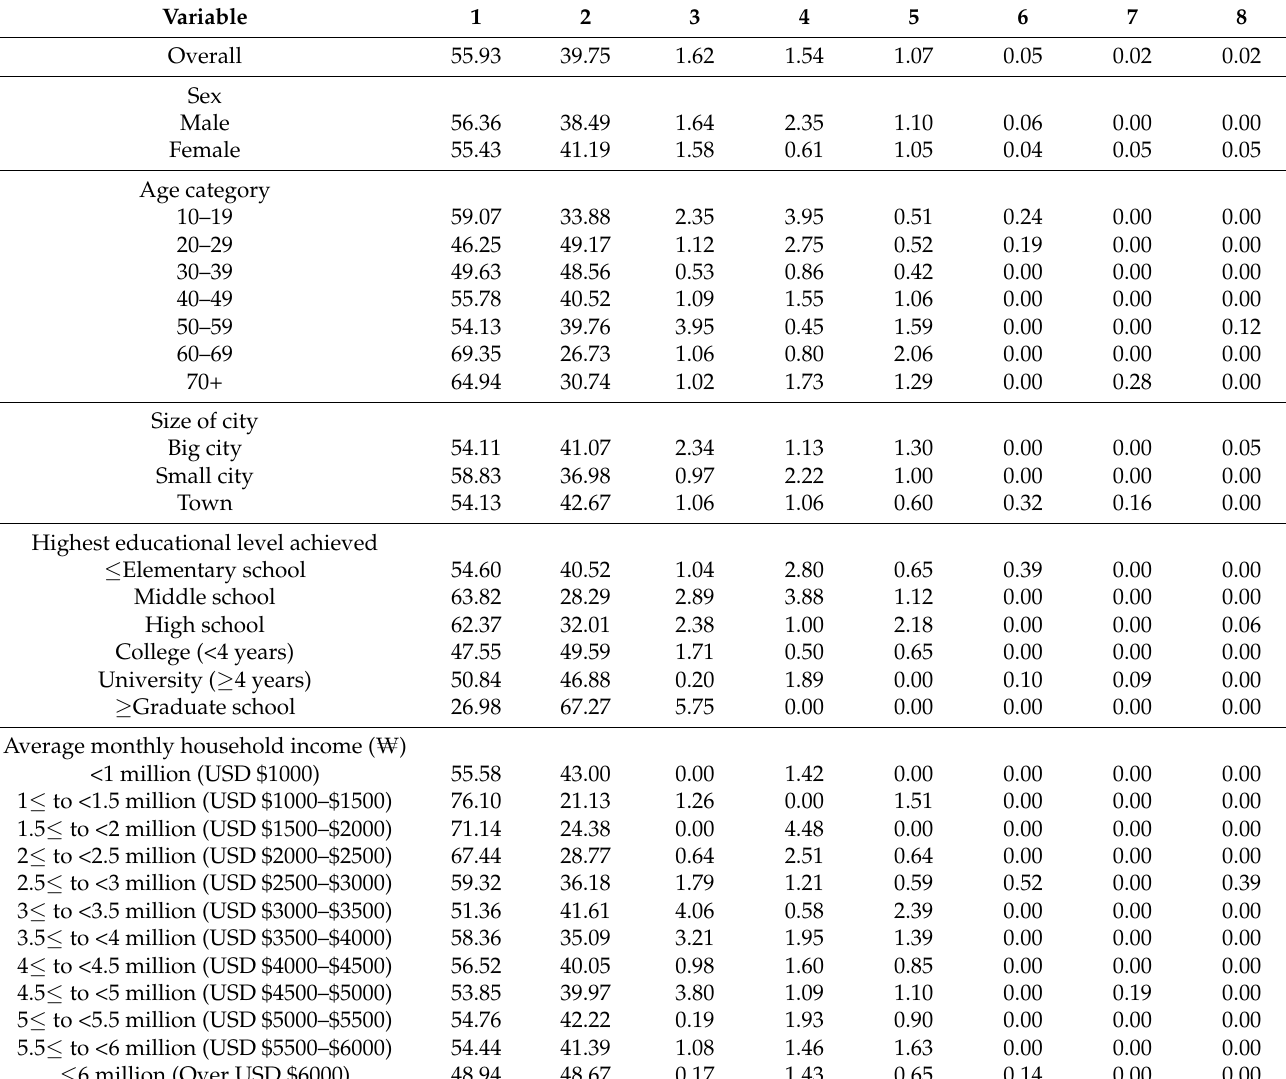
Table 5. Reasons for the change in regular participation in sports activities due to the COVID-19